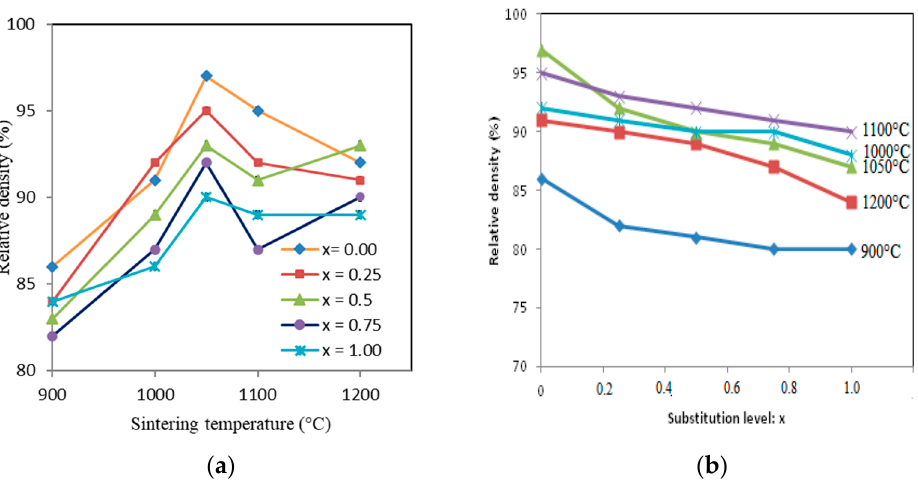
Figure 6. Relative density values (accuracy ± 1.5%) of Ca 10 − x K x (PO 4 ) 6 F (2 − 2 x ) (OH) x for 0 ≤ x ≤ 1 versus. ( a ) Sintering temperature ( b ) Substitution level x.